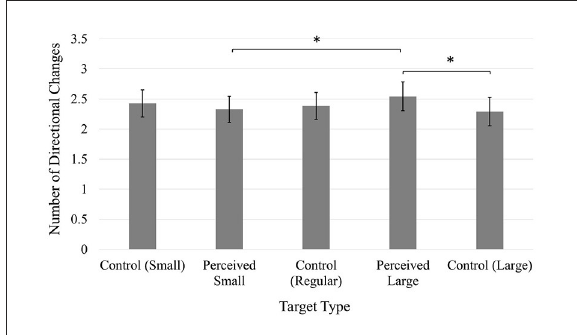
FIGURE4 Average number of directional changes. Error bars represent 95% confidence intervals. * p < 0.05.